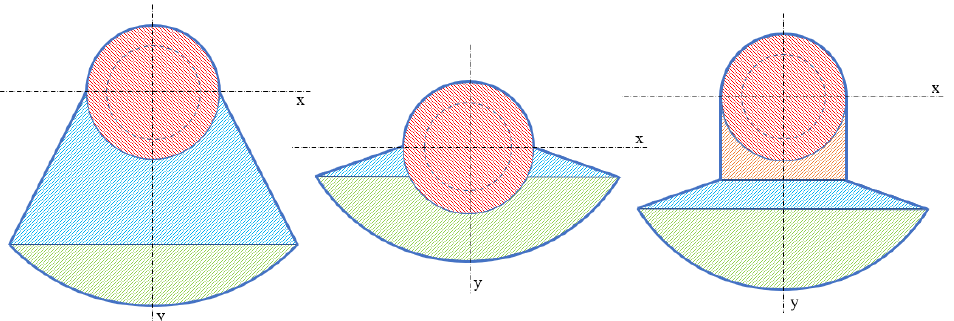
Figure 6. Examples of characterisation of a crankshaft